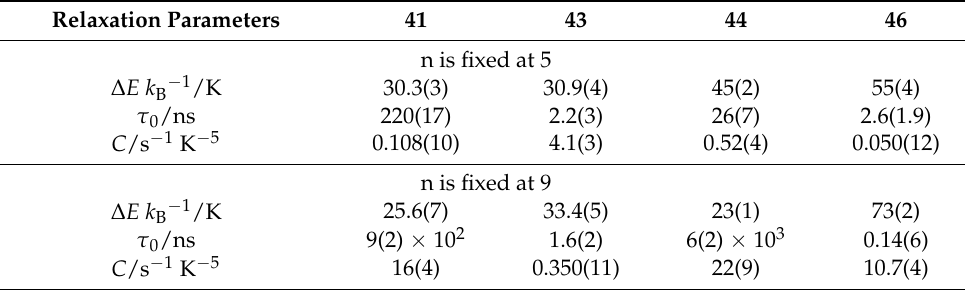
Figure 27. ( A – D ) Arrhenius plots for complexes 41 , 43 , 44 , and 46 respectively measured under a 1000 Oe bias field. Solid lines and dotted curves represent theoretical fitting taking into account the TA-QTM process (black), the TA-QTM and the Raman processes with n = 5 (blue), and the TA-QTM and the Raman processes with n = 9 (red). Figures and caption are reproduced from Reference [63] with permission from the American Chemical Society © 2016. Table 1. Best fitted parameters of Arrhenius